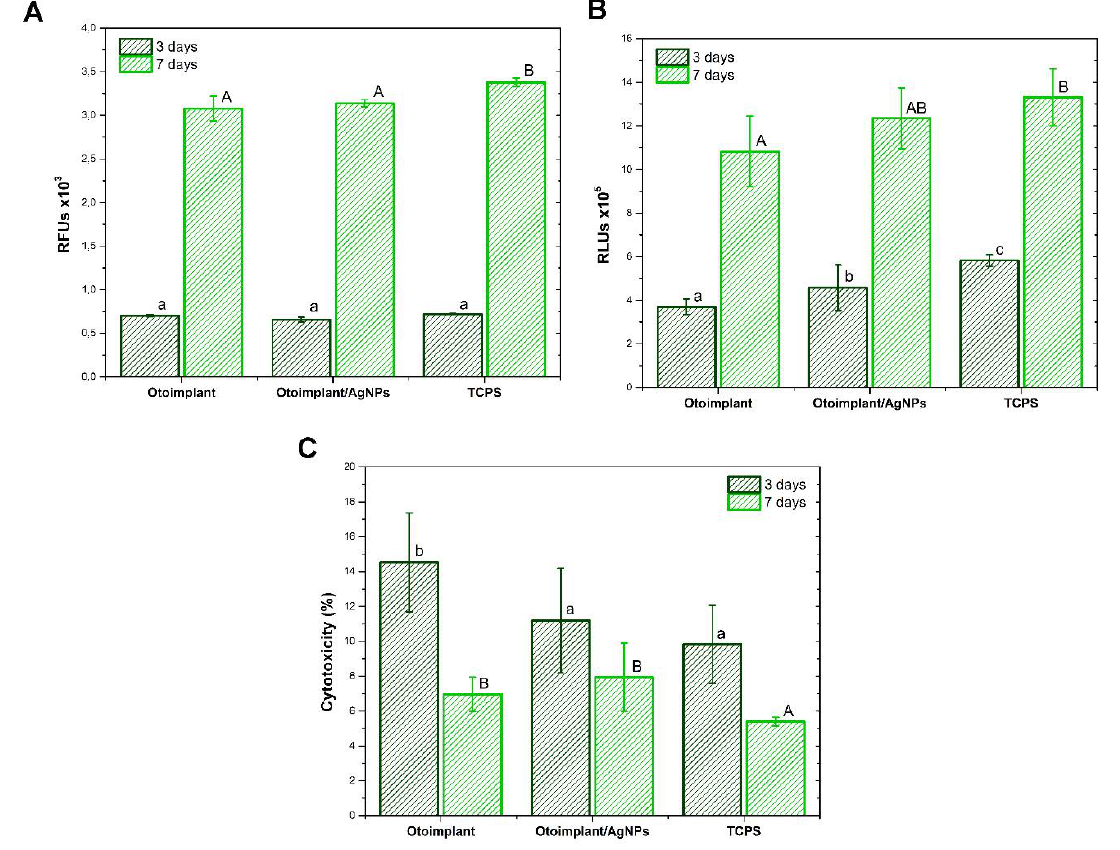
Figure 6. Saos-2 cell response after three and seven days of culture in direct contact with the Otoimplant and Otoimplant/AgNPs: metabolic activity ( A ), the relative cell number ( B ), and cytotoxicity of materials ( C ). Statistically significant differences ( p < 0.05) between the tested materials are marked a–c for three-day culture and A–B for seven-day culture, respectively. TCPS—tissue culture polystyrene. RFUs—relative fluorescence units. RLUs—relative light units.